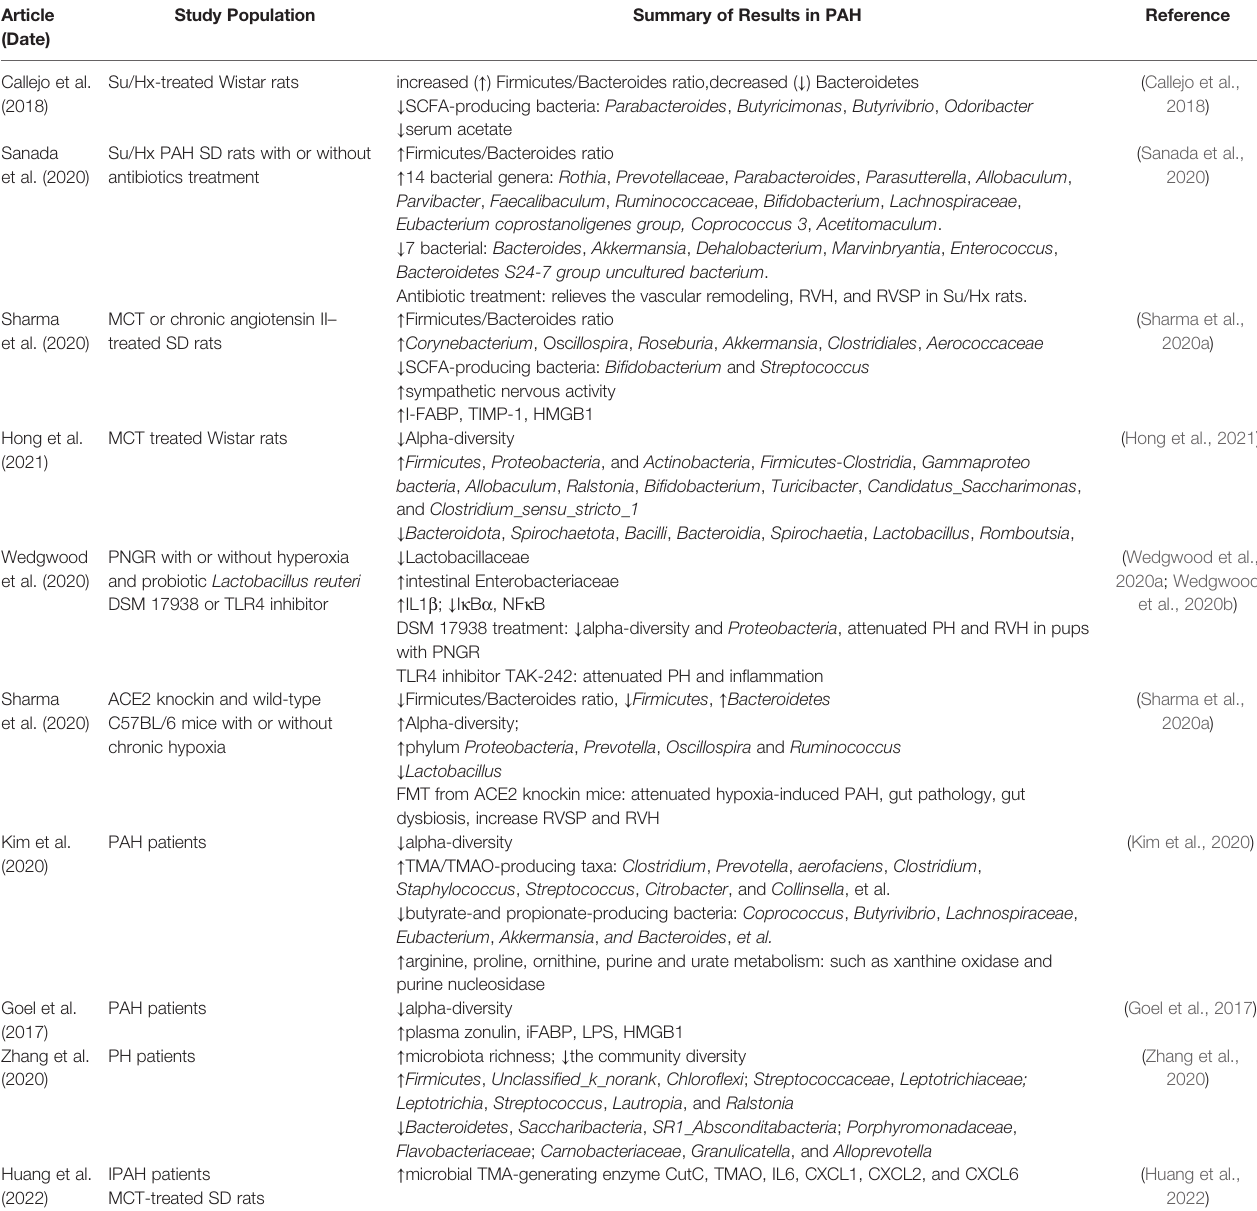
TABLE 1 | Contemporary studies on pulmonary arterial hypertension and alterations in gut